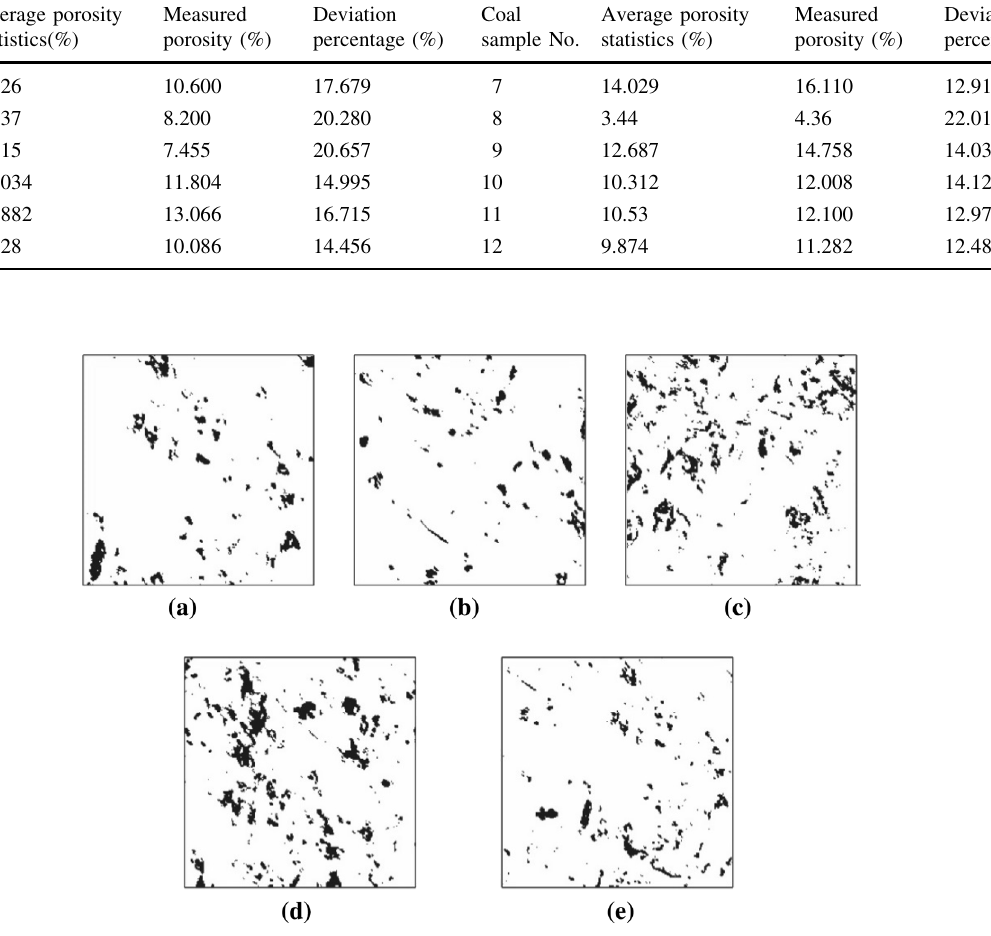
Fig. 9 Processed images of the No. 8 coal sample at 1000 9